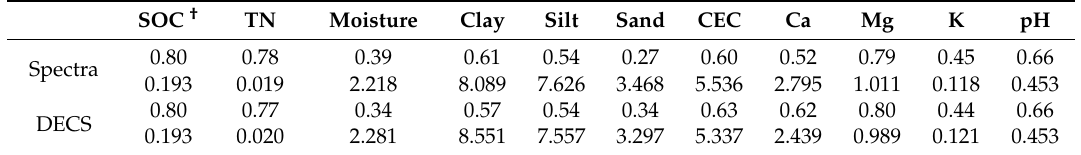
Table 4. Fit statistics for soil property estimation with spectra alone, or the combination of depth, electrical conductivity, cone index, and spectra (DECS), calculated with partial least squares regression (PLSR) and cross-validation on the combined Field 1 and Field 3 dataset. For each cell, the top row is R 2 and the bottom row is root mean square error (RMSE; see Table 1 for units).